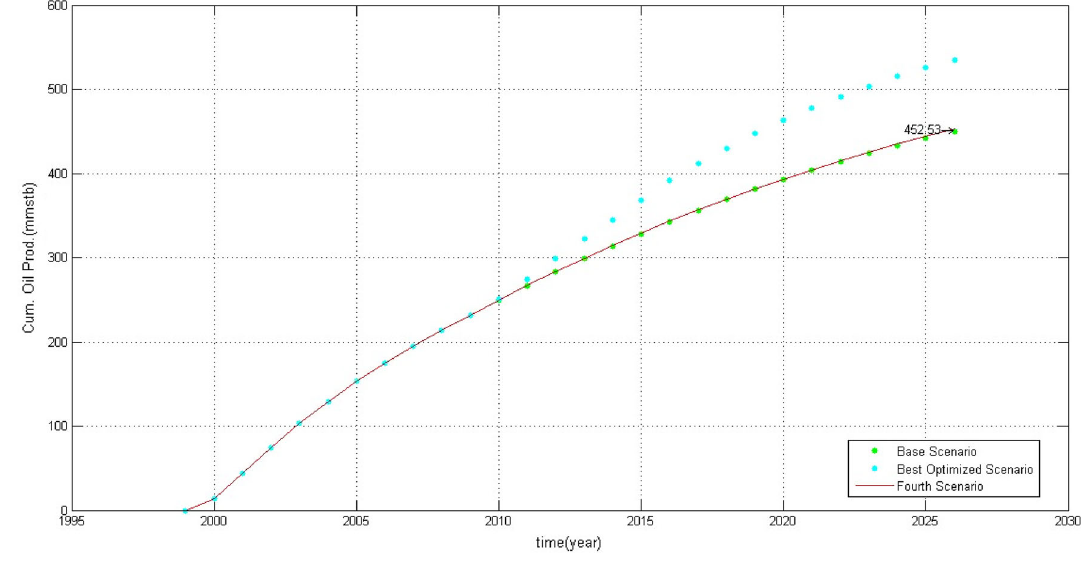
Fig. 8 Cumulative oil production of fourth scenario